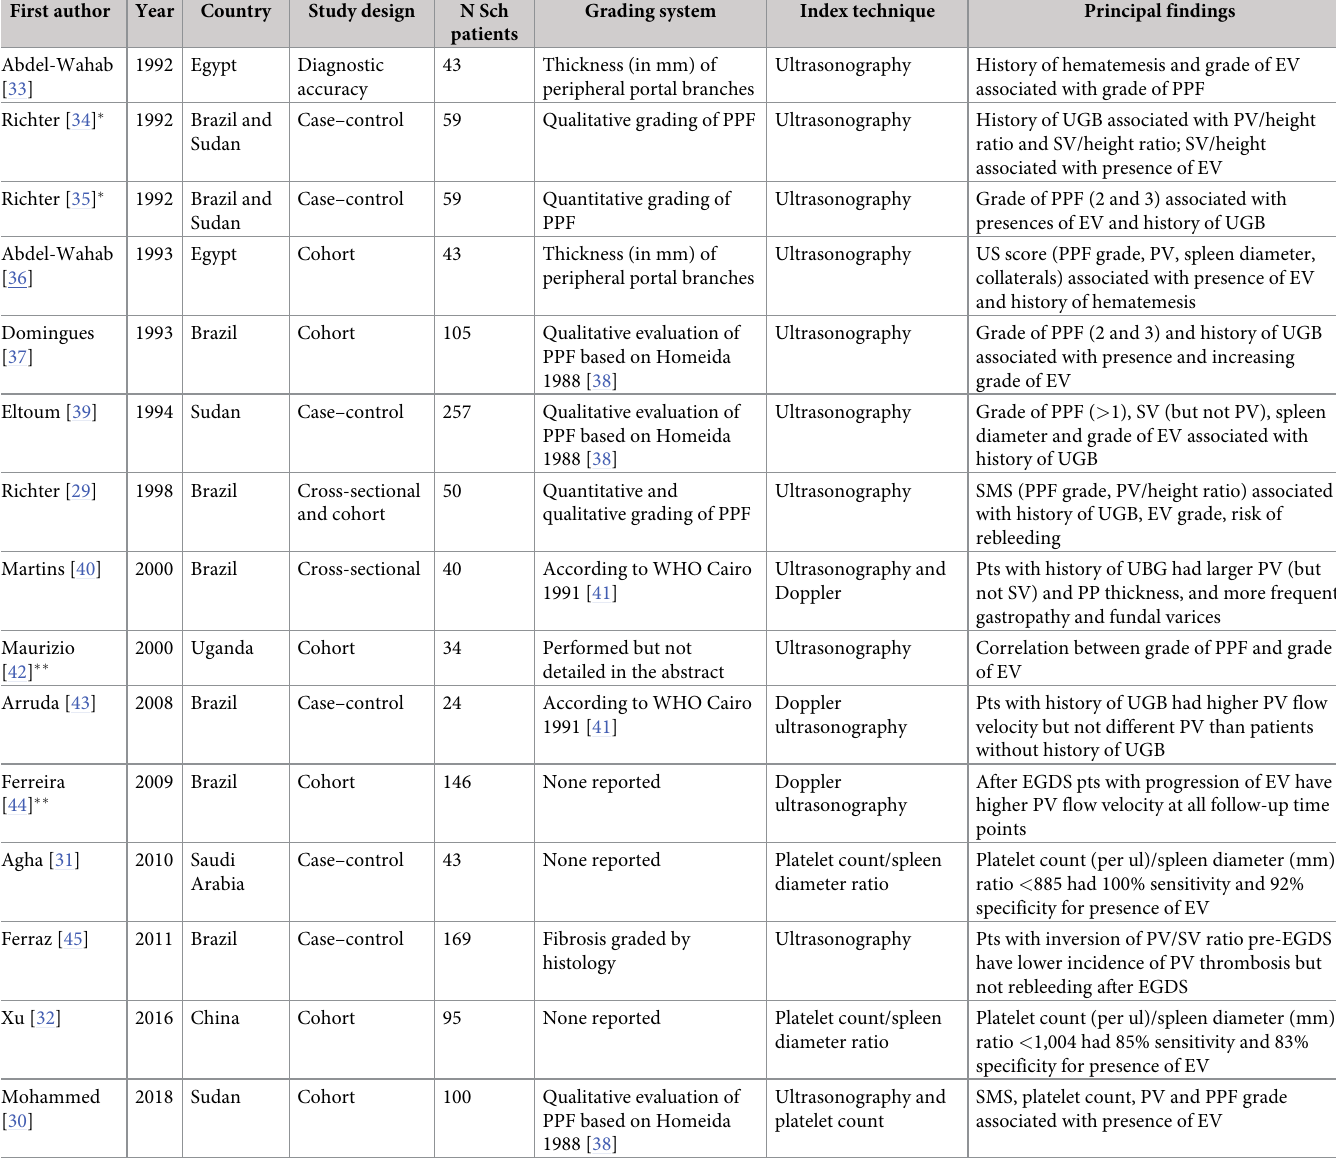
Table 2. Summary of the included studies investigating diagnostic parameters for the diagnosis and prognosis of the complications of hepatosplenic schistosomiasis.